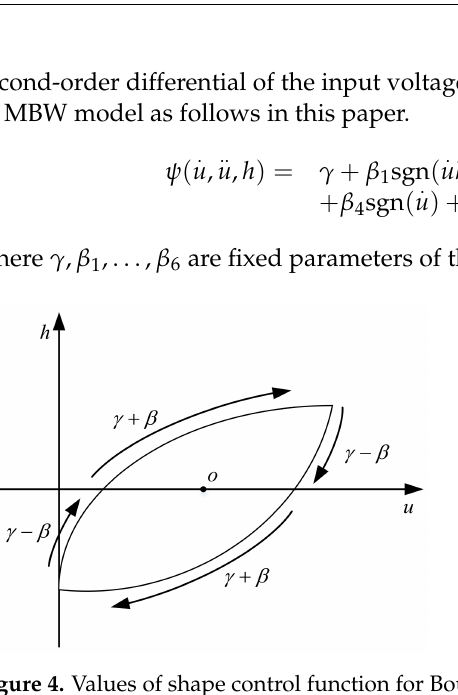
Figure 4. Values of shape control function for Bouc–Wen model.